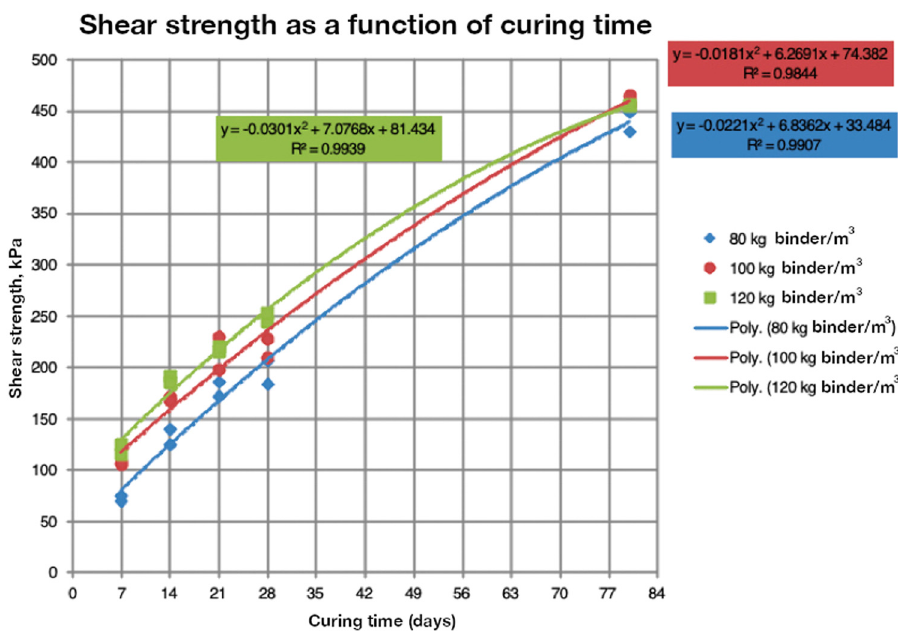
Figure 3: Shear strength as a function of curing time for specimens stabilised with a binder combination of CEM II/A and quicklime ( 50/50 ) . The amounts of binder corresponded to 80, 100, and 120 kg of binder per m 3 of clay. The samples are stored in climate rooms with a temperature of 7 °C